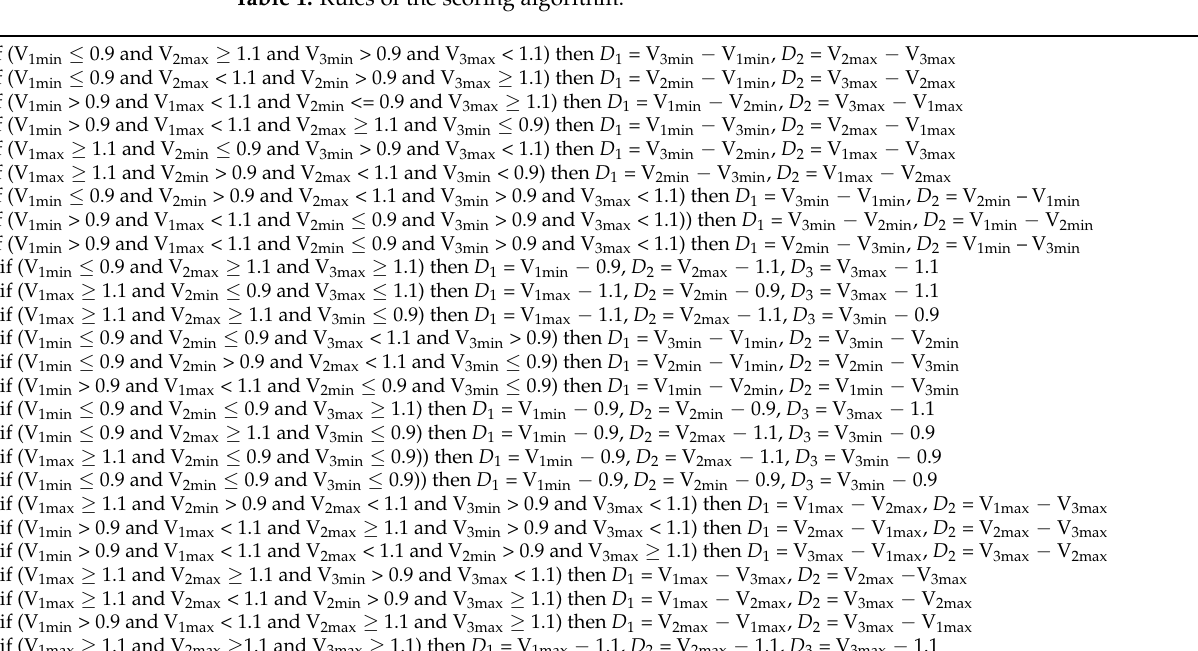
Figure 4. Flowchart diagram of fault type algorithm. Table 1. Rules of the scoring